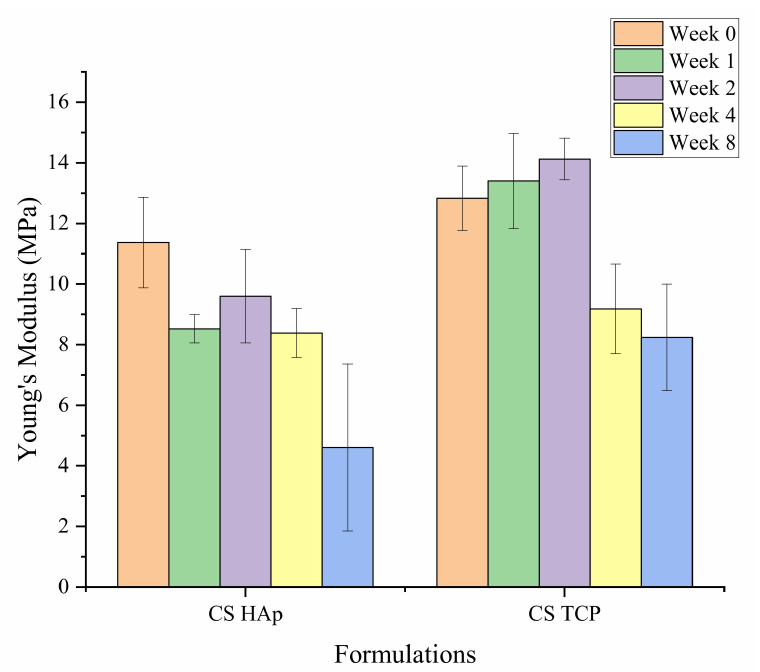
Figure 10. The compressive strength profile of the scaffolds while degrading in SBF for CS/HAp and CS/TCP- α , showing a reduction in the scaffold strengths over the eight